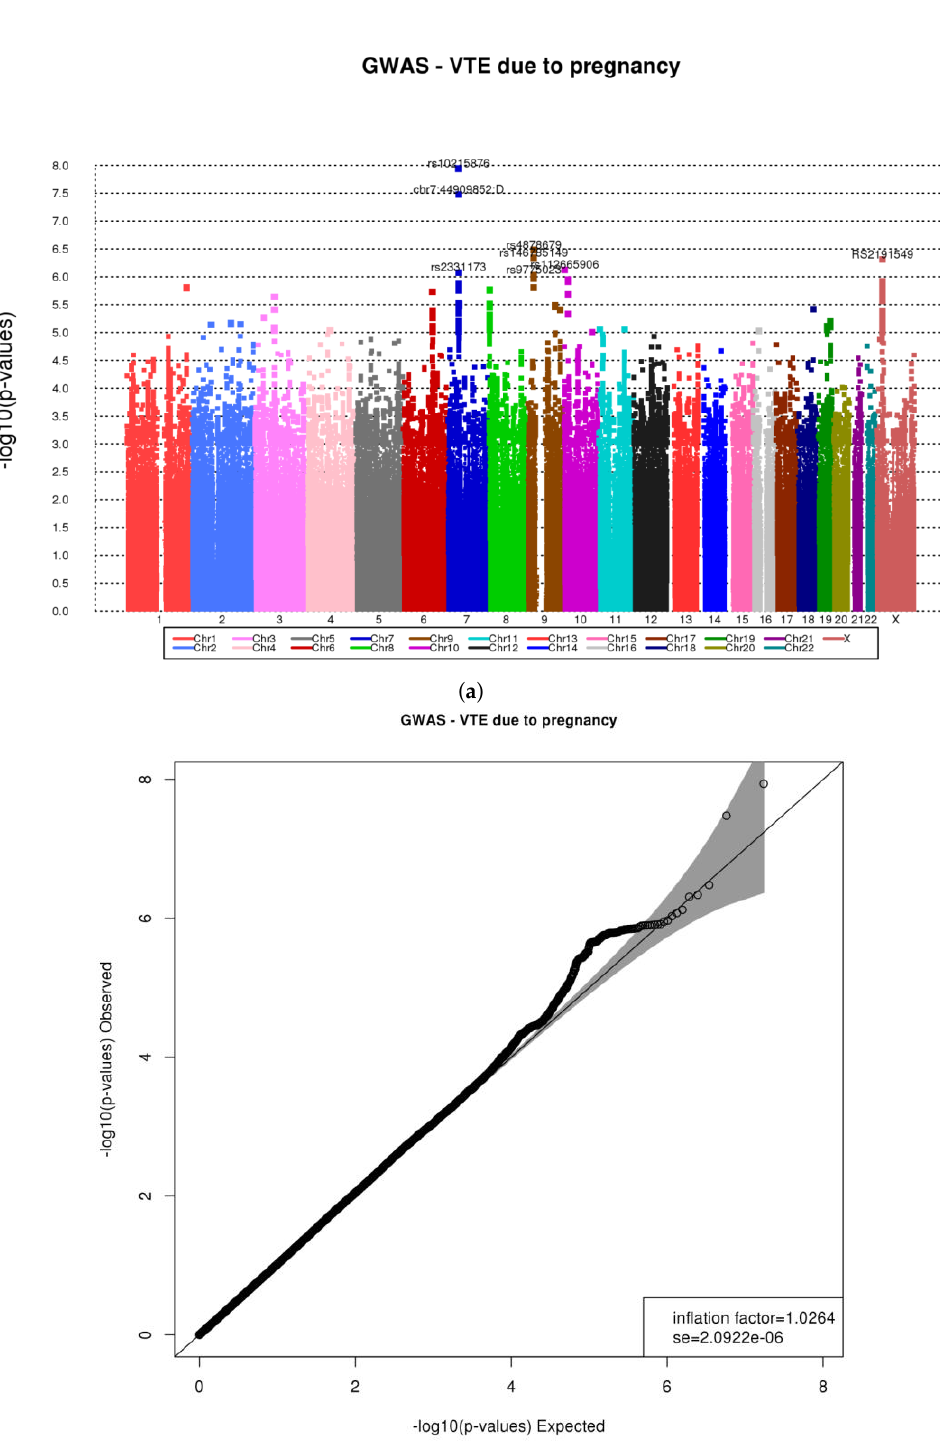
Figure 1. ( a ) Manhattan plot for the genome-wide association (GWA) for pregnancy-related venous thromboembolism (VTE) with the two significant single nucleotide polymorphisms (SNPs) within the expected level of significance; ( b ) QQ plot for the genome-wide association (GWA) for pregnancy-related VTE with the two significant SNPs within the expected level of significance, the gray area indicating that they are not spurious results. GWAS: genome-wide association